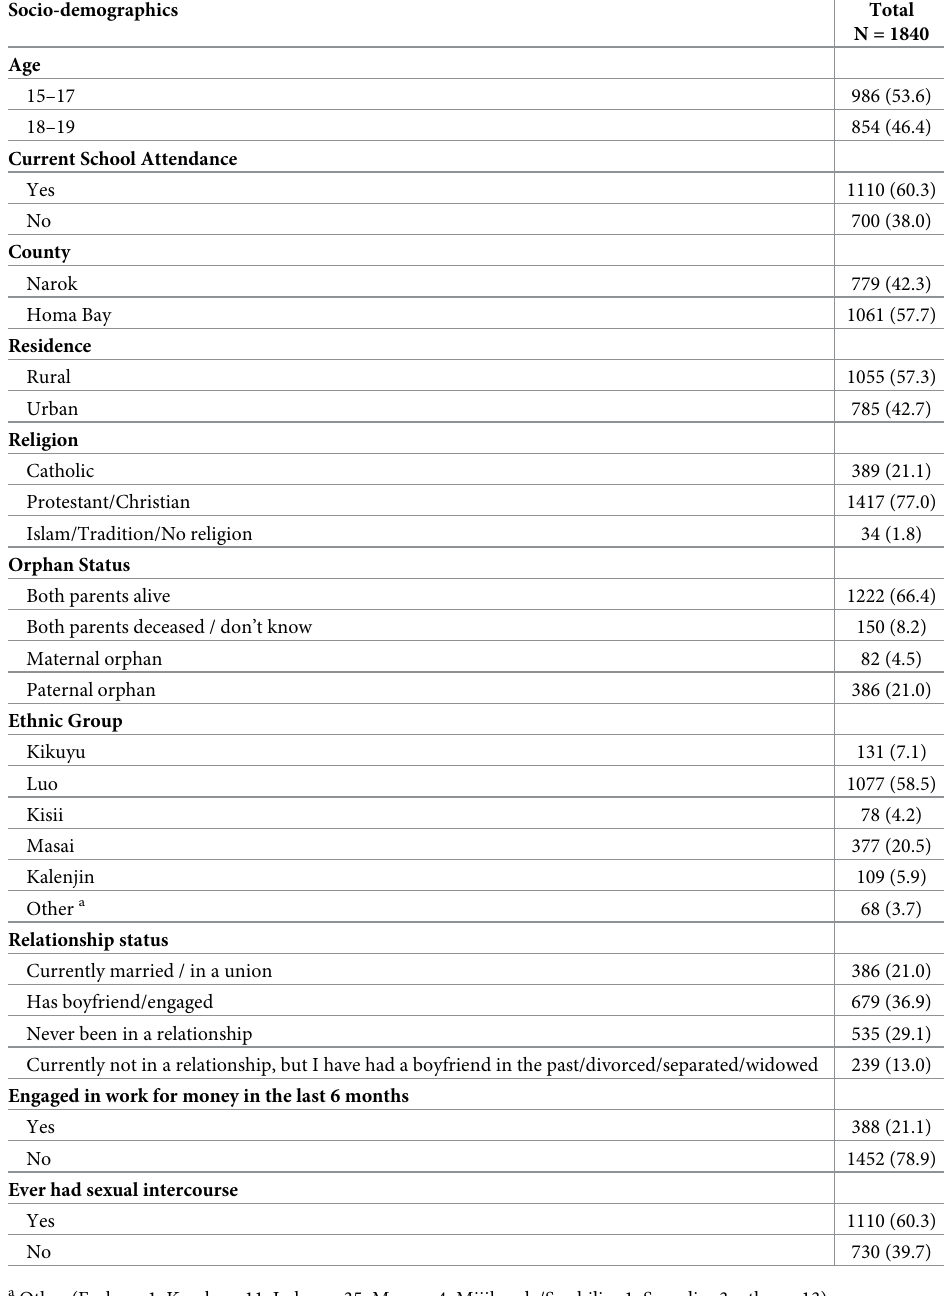
Table 1. Socio-demographic characteristics of adolescent participants aged 15–19 in Kenya.